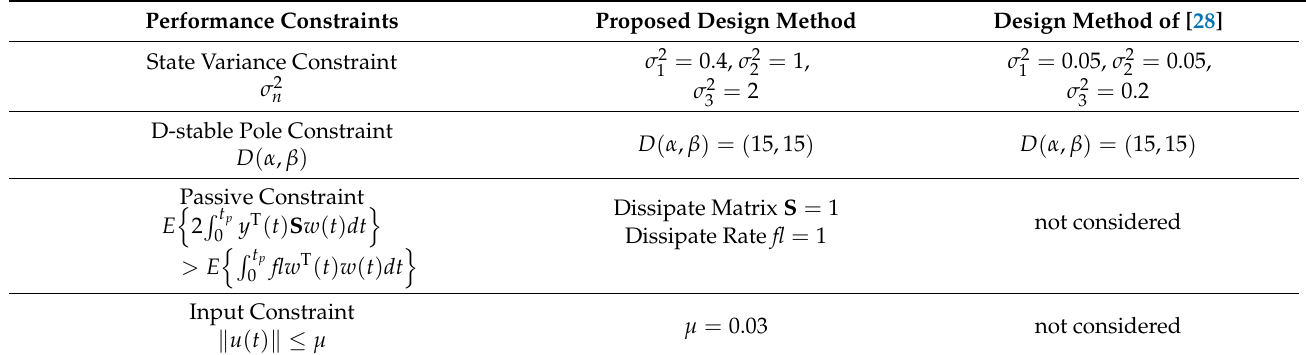
Table 2. Selected multiple performance